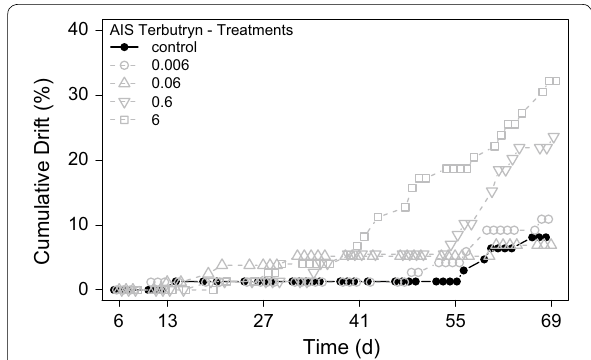
Fig. 6 Cumulated overnight drift activity of grazers during the terbutryn experiment. Cumulation started at t 6 after stabilization of grazer drift caused by adaptation of grazers to the AIS